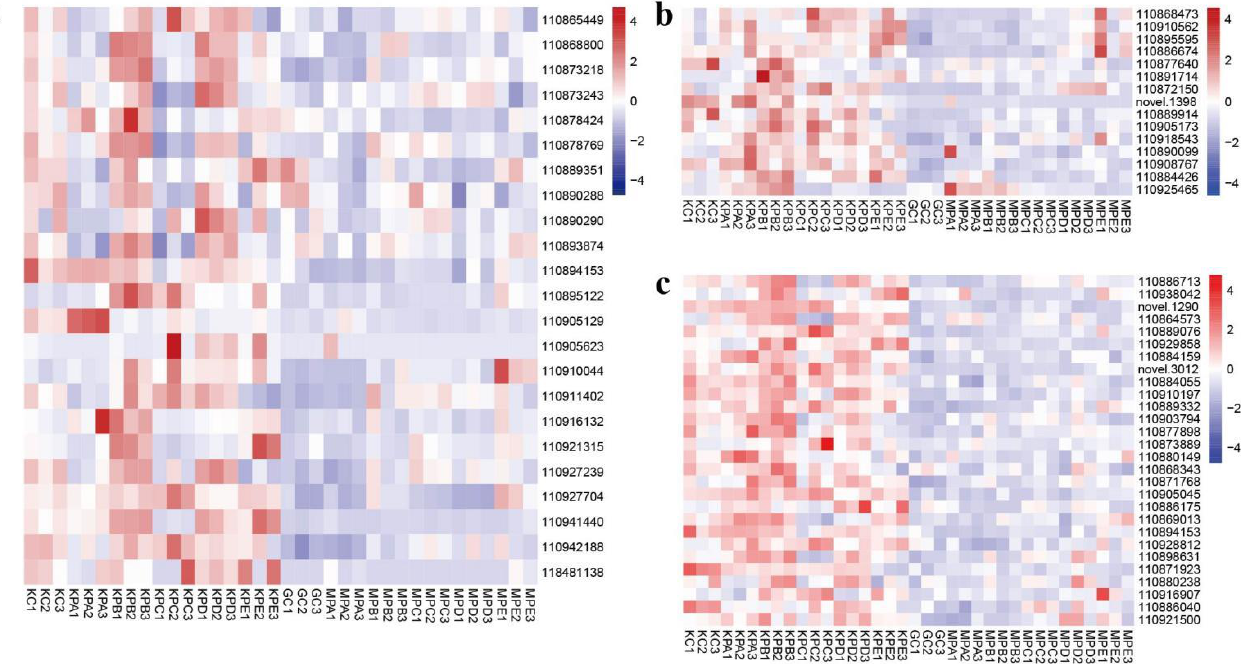
Figure 9. Heatmap of the different pathways. ( a ) Heatmap of differentially expressed genes in plant – pathogen interaction signaling pathway; ( b ) heatmap of differentially expressed genes in phenylpropanoid biosynthesis pathway; ( c ) heatmap of differentially expressed genes in plant hormone signal transduction pathway.